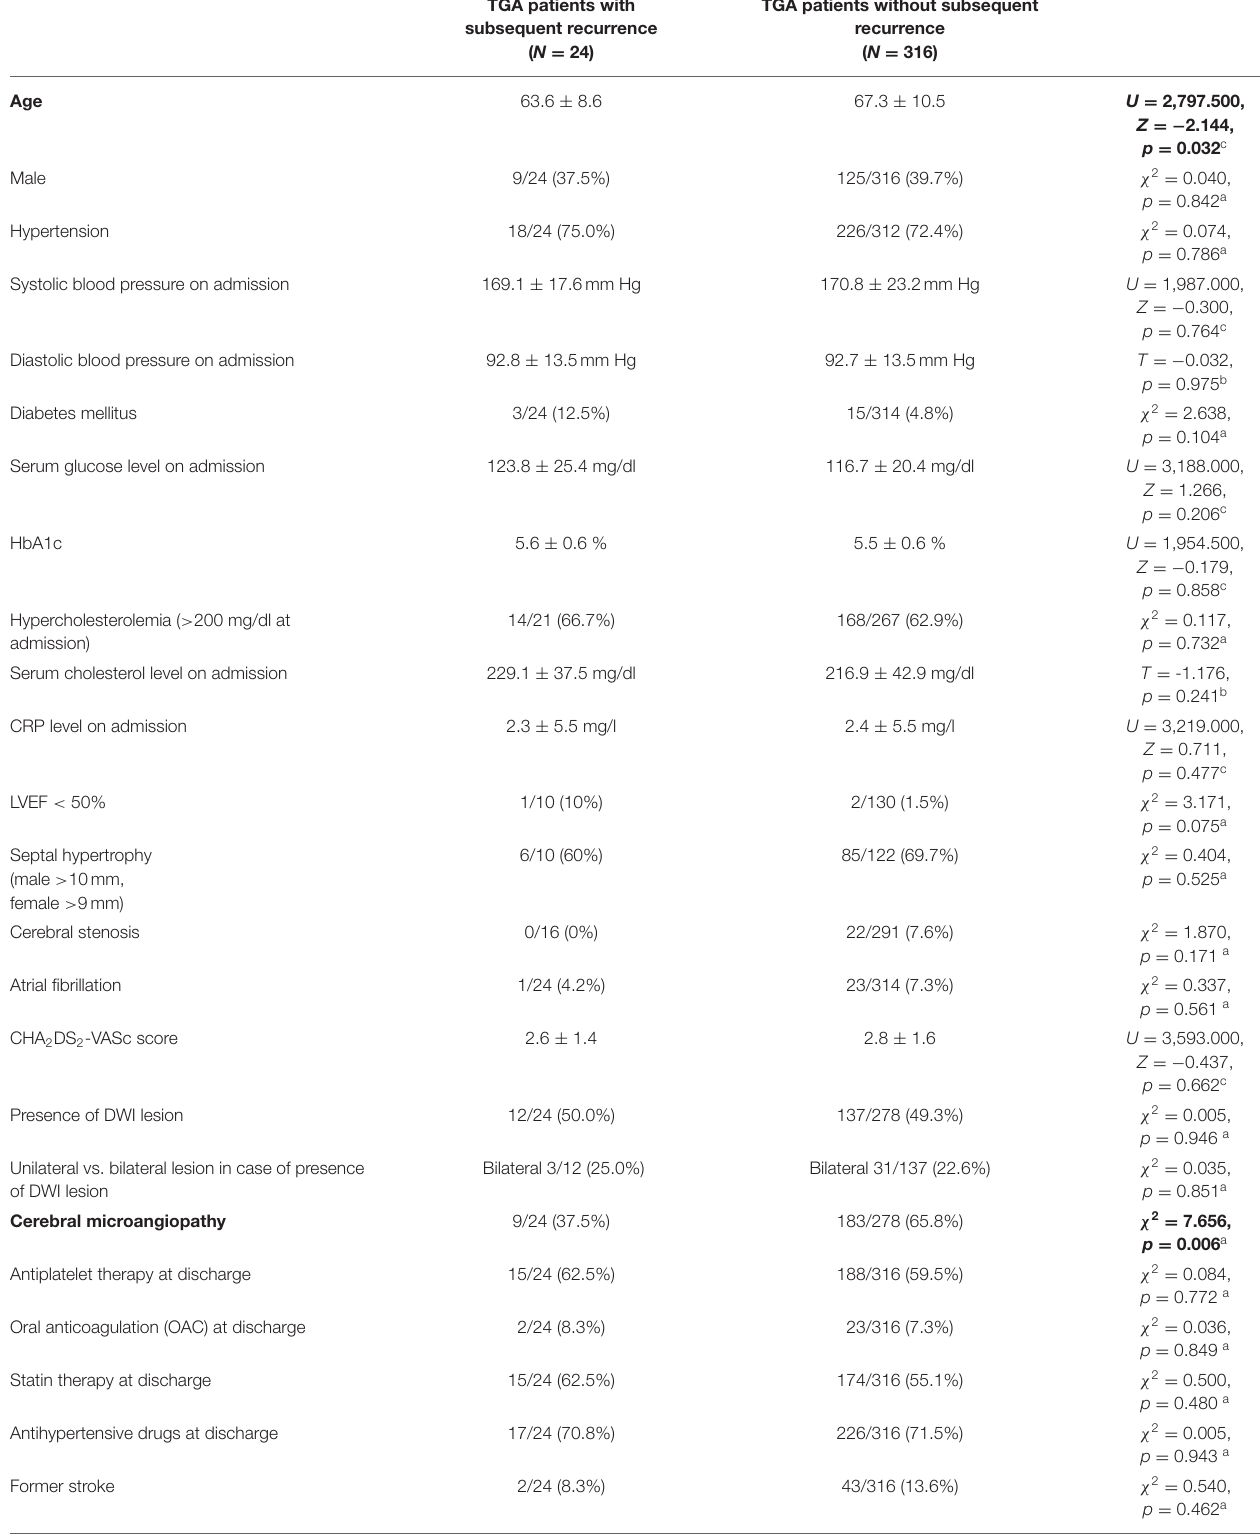
TABLE 1 | Comparison of TGA patients with vs. without subsequent recurrence ( N =